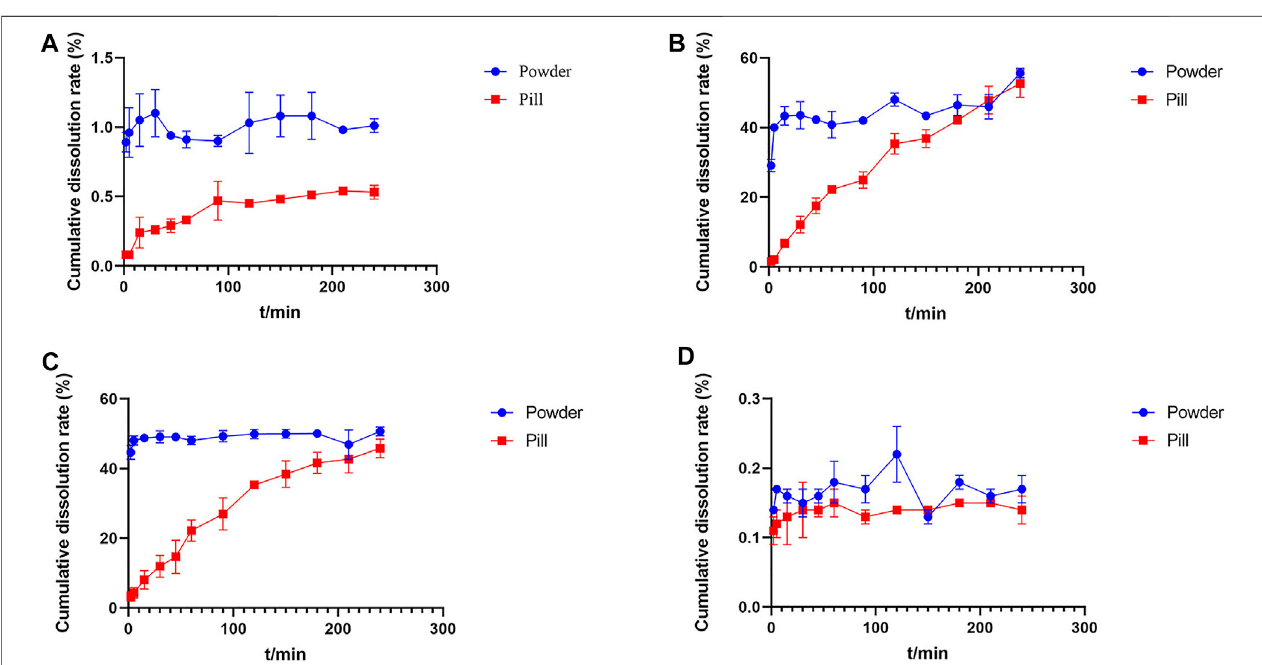
FIGURE2| Dissolution curves oftetramethylpyrazine,ferulic acid, nodakenin, and isoimperatorin inChuanxiong Chatiaopowderand pill. (A) Tetramethylpyrazine, (B) ferulic acid, (C) nodakenin, and (D) isoimperatorin.